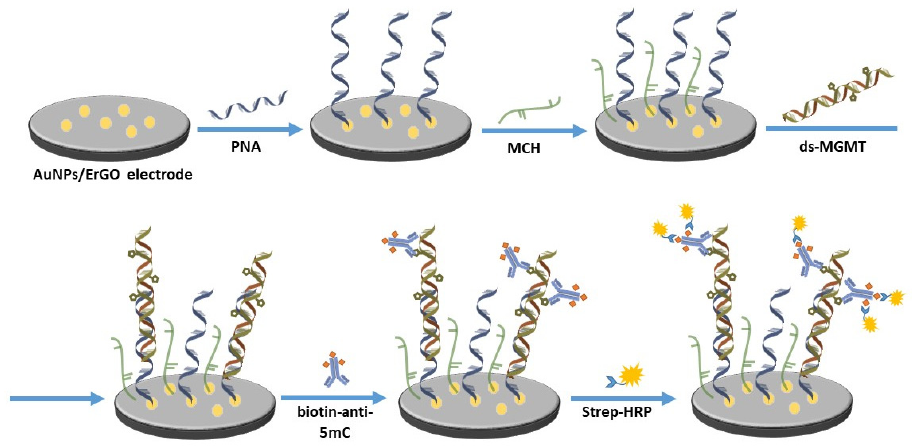
Figure 1. A schematic of the developed biosensor. The preparation of the AuNPs/ErGO electrode is depicted in Figure